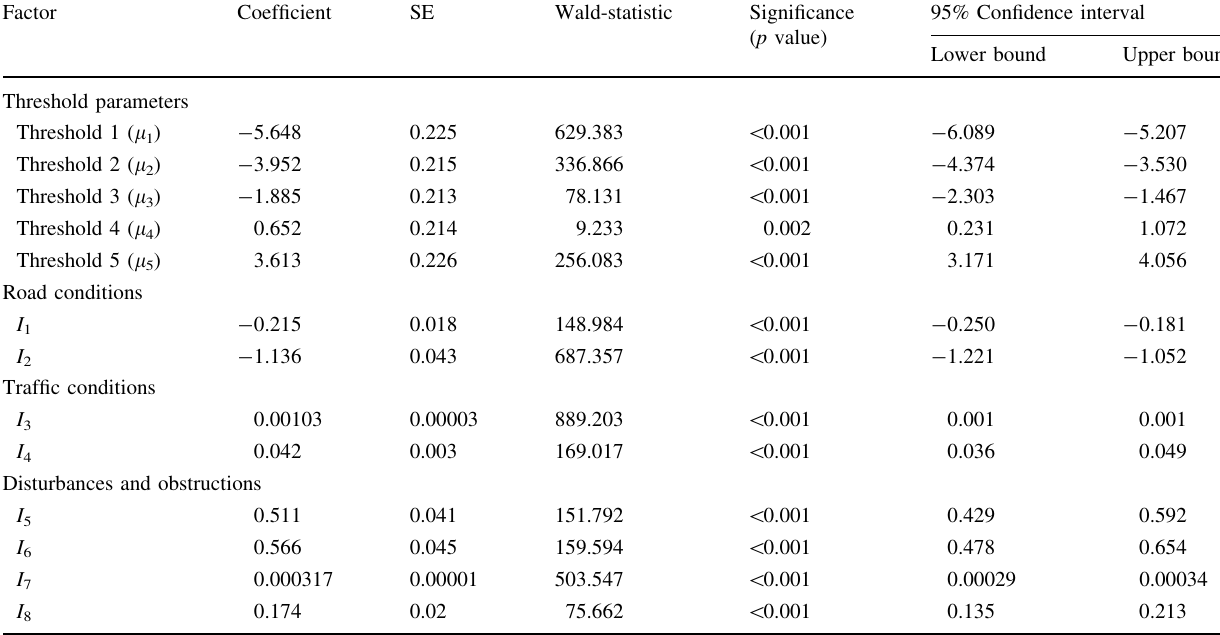
Table 4 Ordered probit model